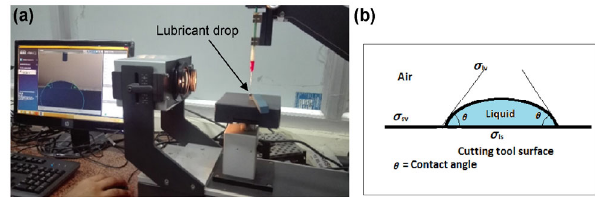
Fig. 3 (a) Contact angle measurement setup; (b) schematic diagram showing a liquid droplet on solid surface.